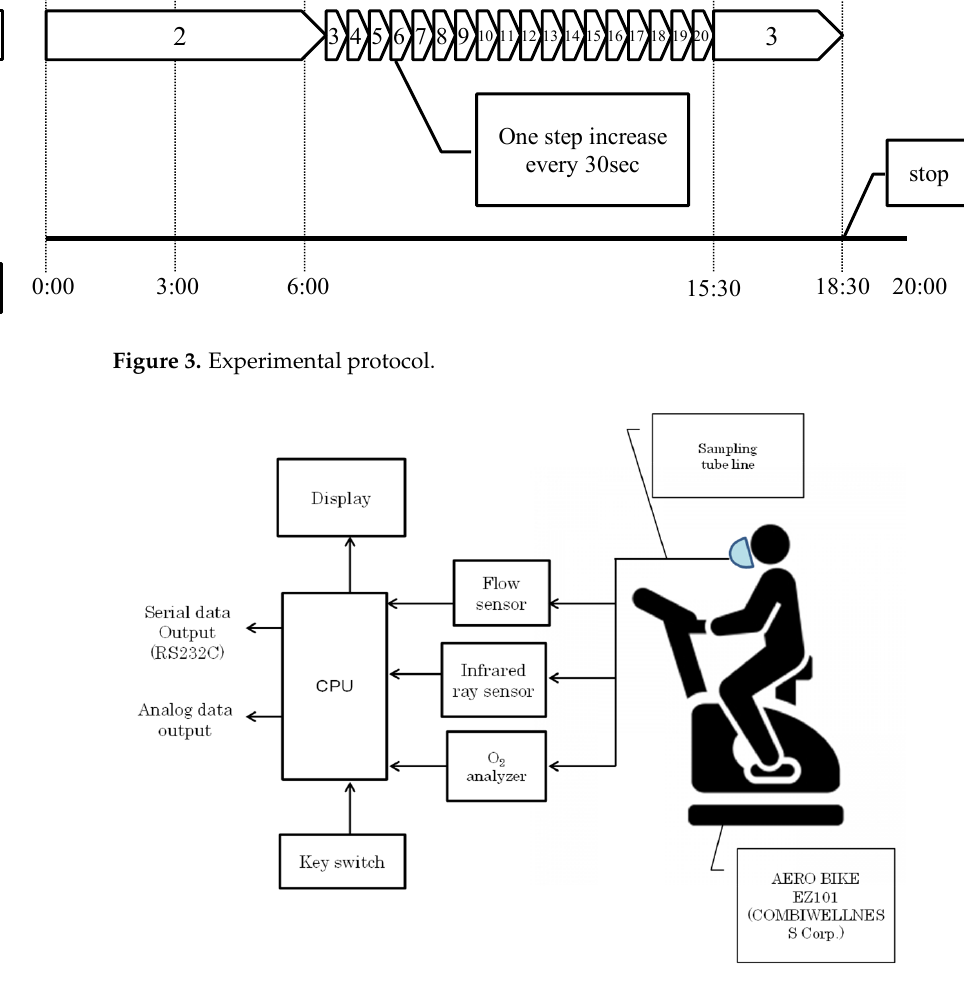
Figure 4. Experimental setup.